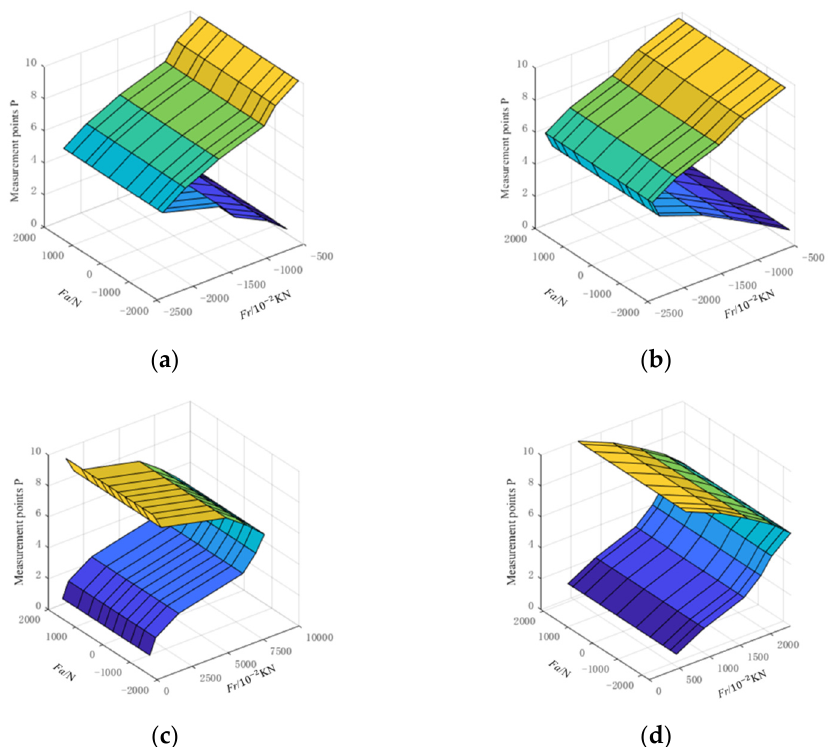
Figure 18. The primary side winding electromagnetic force: ( a ) primary winding 1 radial and axial forces; ( b ) primary winding 2 radial and axial forces; ( c ) primary winding 3 radial and axial forces; ( d ) primary winding 4 radial and axial forces.